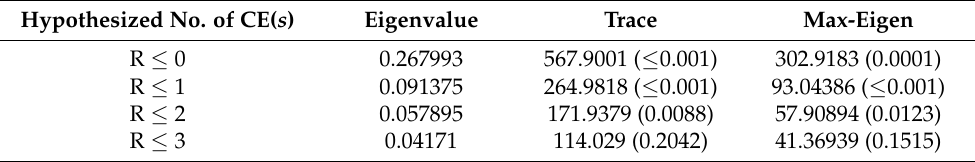
Table 4. Johansen co-integration test.